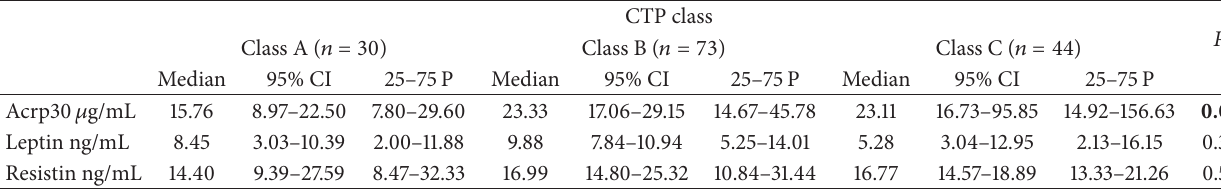
Table 6: Serum adipokine levels in patients with ALD according to the CTP class.